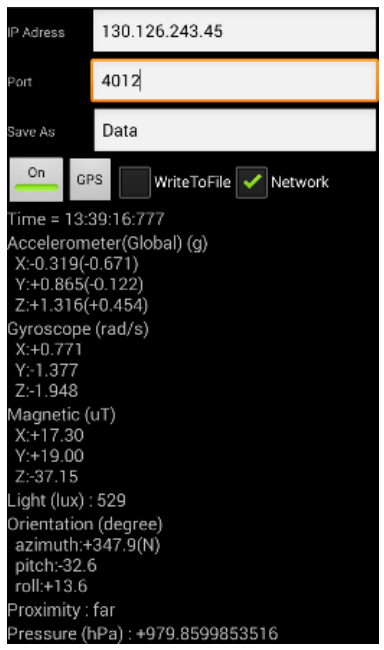
Figure 3. Android application for data collection.